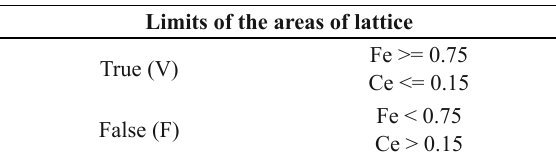
Limits of the areas of lattice for decision-making used in morphological